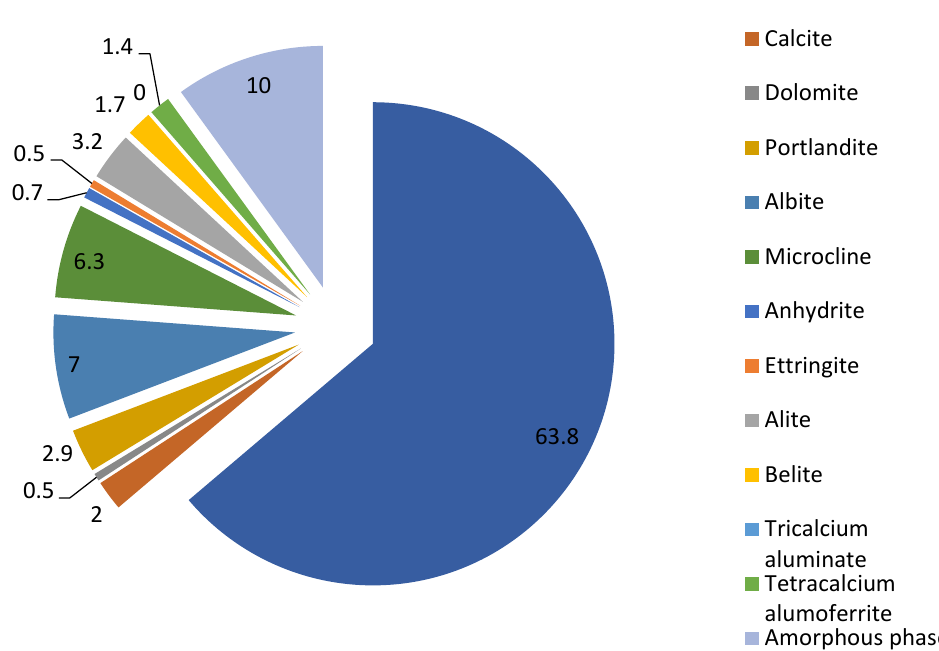
Figure 20. Mineral composition of the developed composite, wt. %.